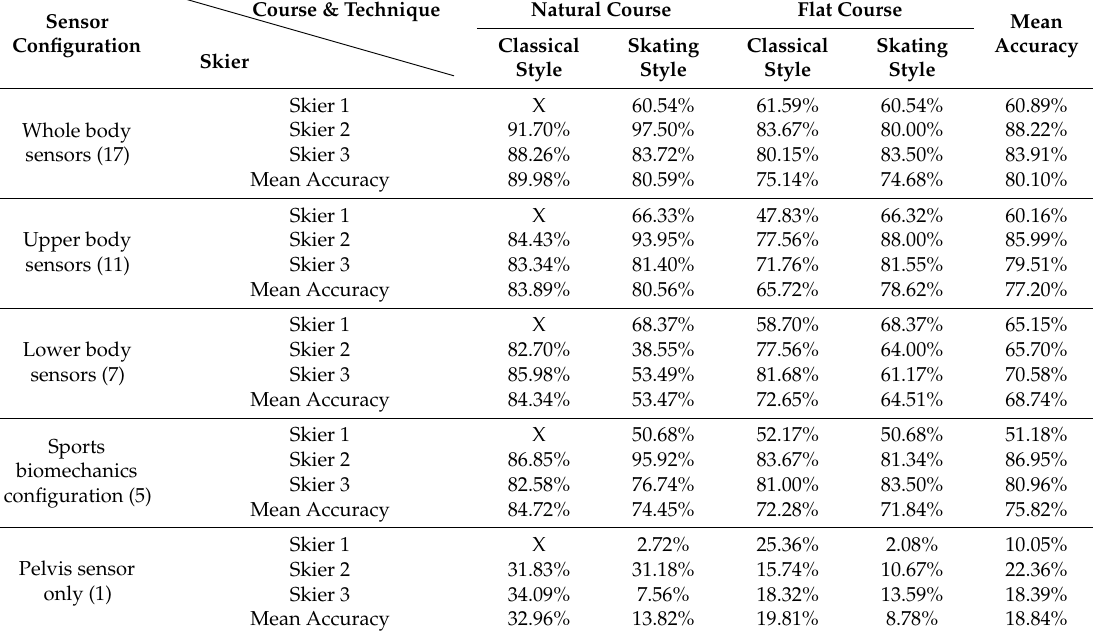
Table 20. Classification accuracies for the validation dataset for five different sensor configurations using the k-nearest neighbors algorithm.